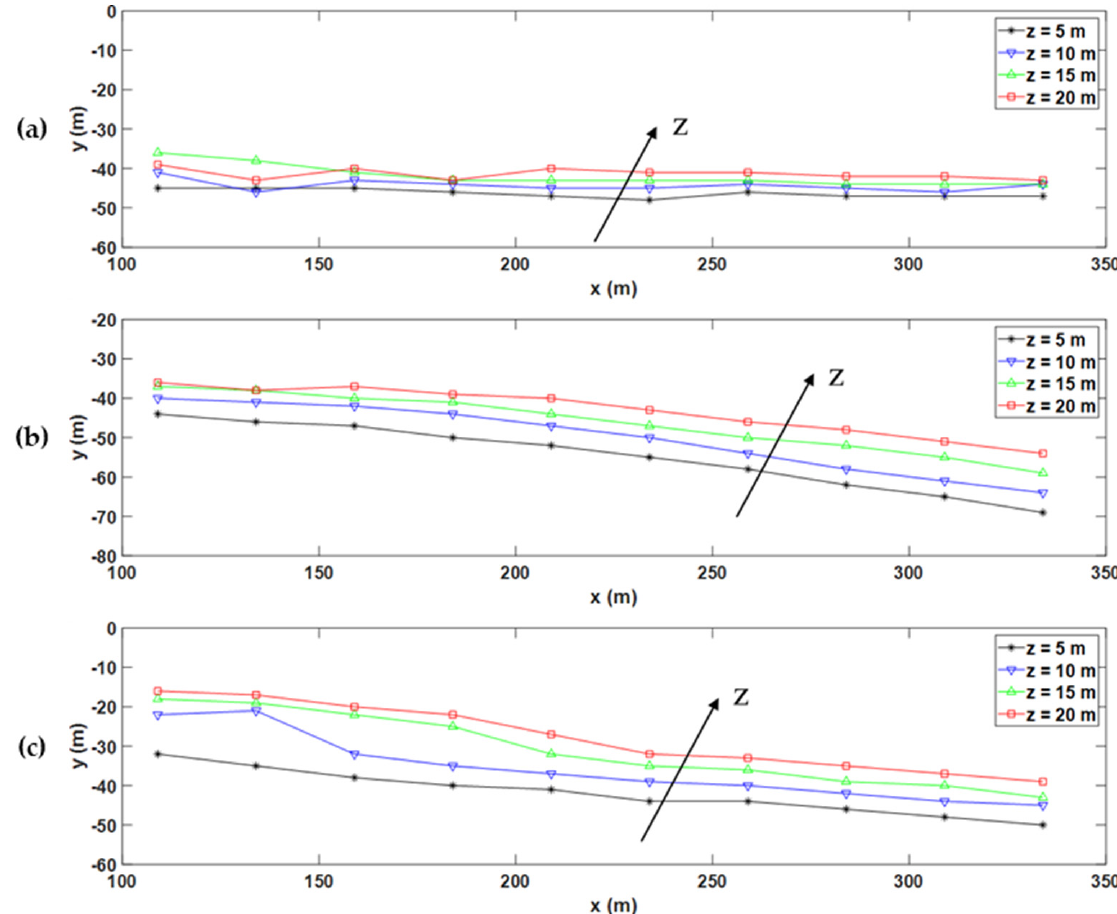
Figure 7. Trajectories of maximum deficit of mean along-wind velocity in the lateral direction at different heights: ( a ) 22.5 ◦ ; ( b ) 45 ◦ ; ( c ) 67.5 ◦